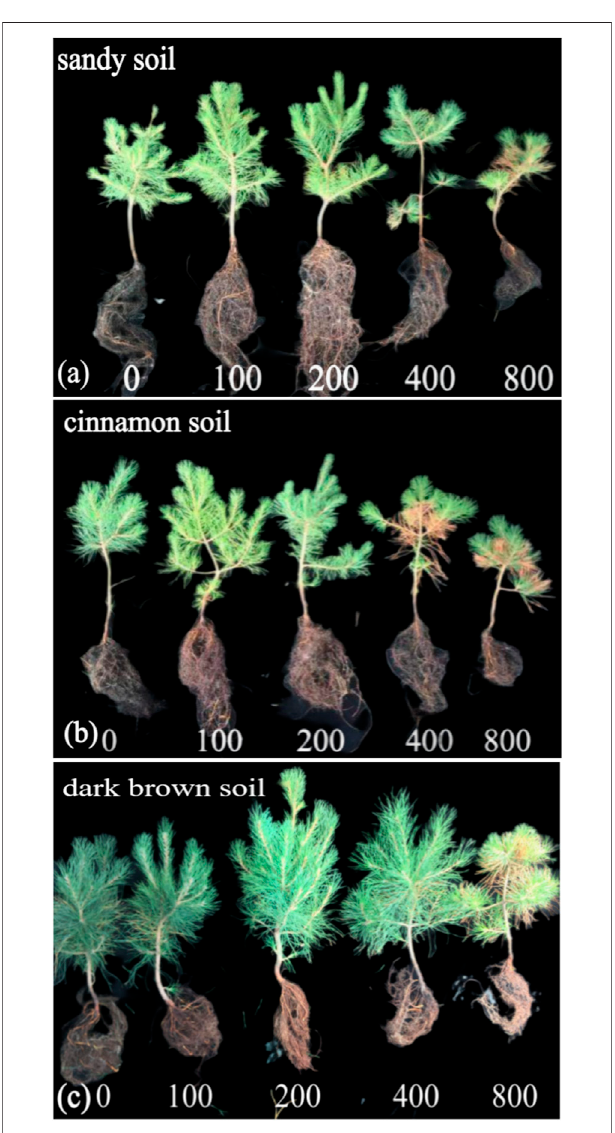
FIGURE 1 | Effects of exogenous calcium on the growth status of Mongolian pine seedlings in different soil types.